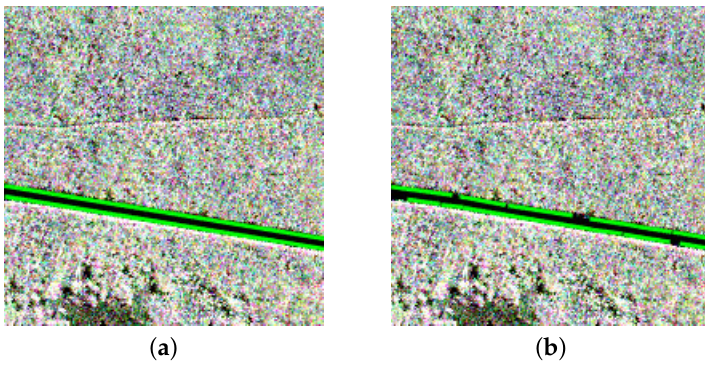
Figure 15. Line segment detection results for different values of D . ( a ) D = 0.4. ( b ) D =